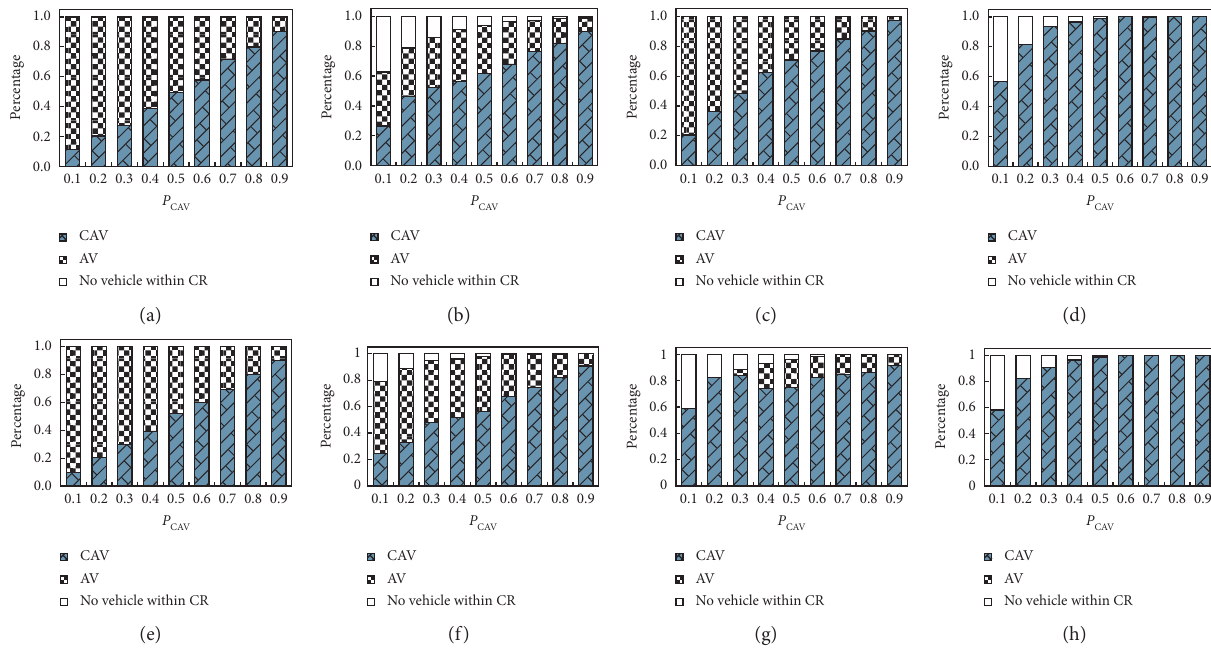
Figure 6: The percentage of each state of CAVs. (a) GG. (b) GC. (c) GM. (d) CM. (e) GGG. (f) GCG. (g). CGC. (h) CCM.